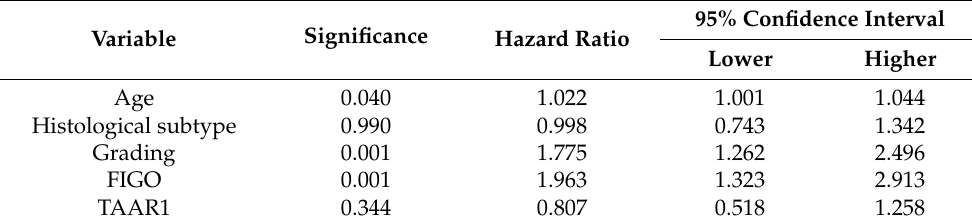
Table 1. Cox regression analysis.